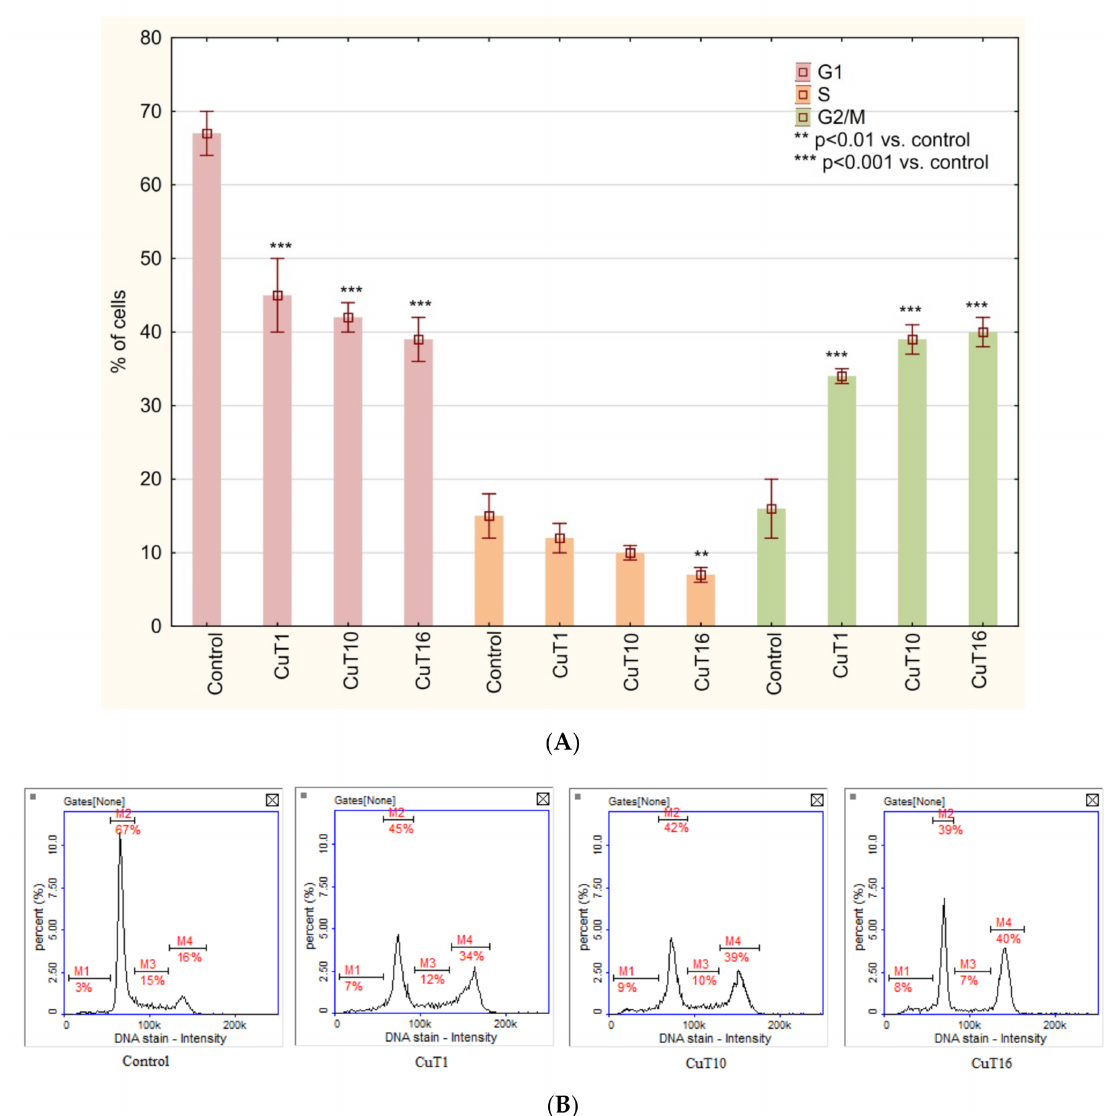
Figure 8. ( A ) Cell cycle analysis based on DAPI staining and image cytometry measurement. A375 cells were treated for 24 h with CuT1, CuT10, and CuT16 compounds in concentration corresponding to appropriate IC 50 value (69.92, 26.05, and 144.60 µ M respectively) or DMSO as vehicle in control cultures. Data presented as mean ± SD derived from three independent experiments. ( B ) Representative histograms (M1: subG1, M2: G1, M3: S, M4: G2/M